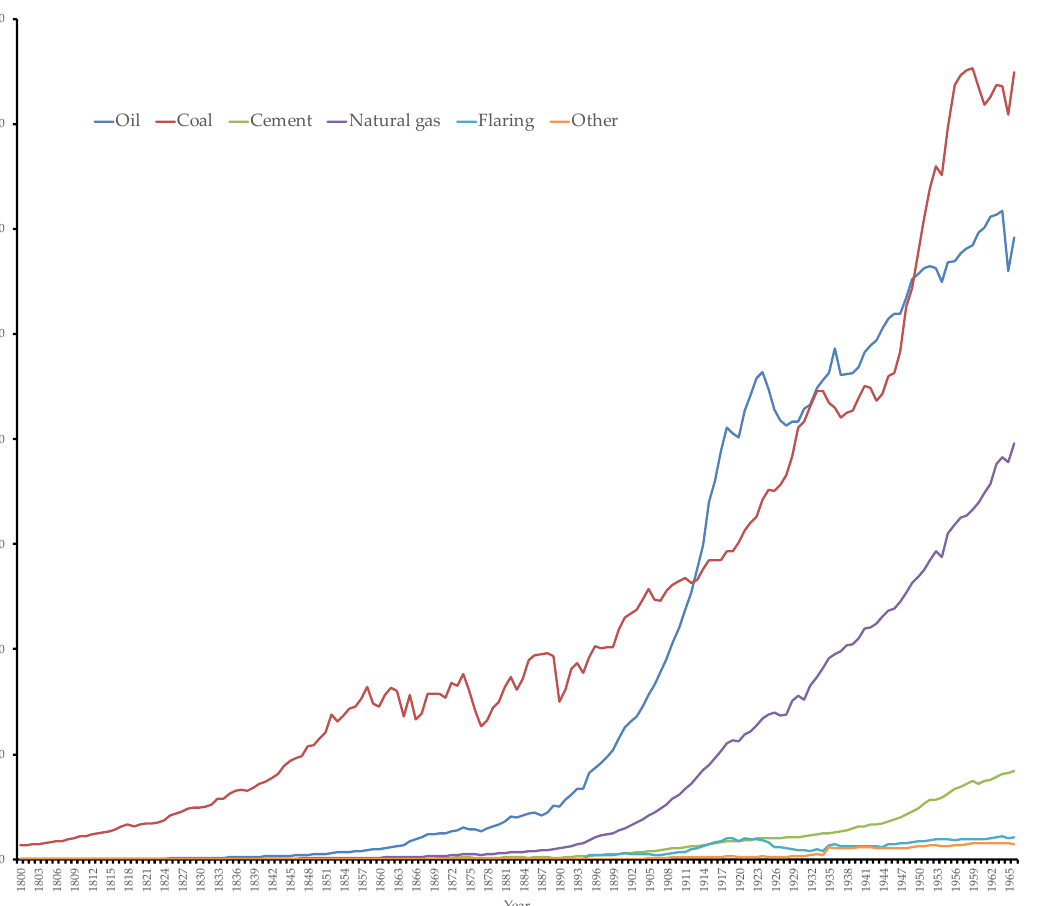
Figure 2. Annual global carbon CO2 by fuel or industry from 1800 to 2021 adapted from https://www.statista.com/, accessed on 15 March 2023).